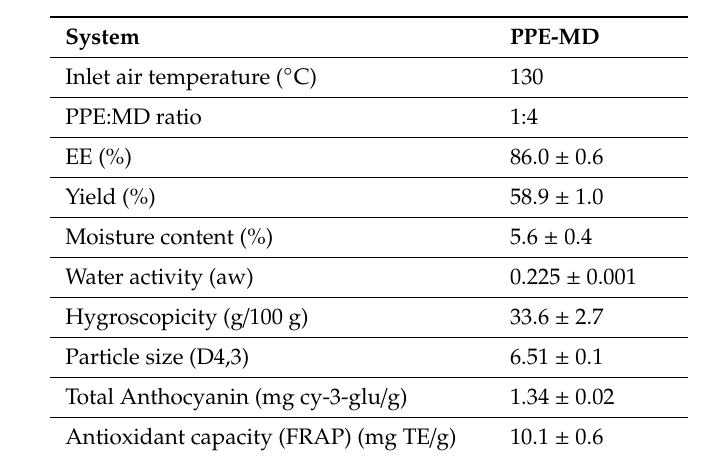
Table 3. Physical and chemical characterization of PPE-microparticles obtained under optimal